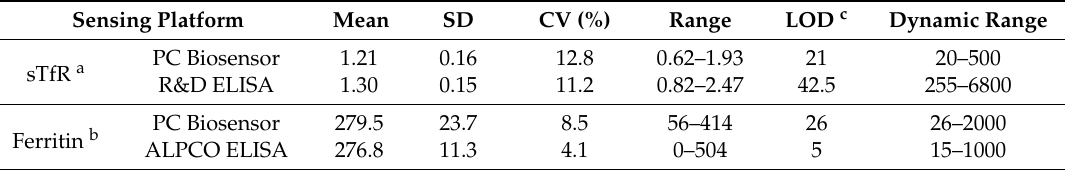
Table 1. Performance, means, SD, coefficient of variations, and range of measurements for all biosensing platforms and analytes.